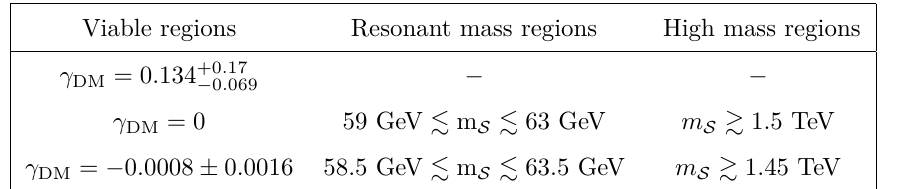
Table 3 . The viable regions in the resonant mass and high mass regions under the limits of LUX2016 for the three γ cases DM